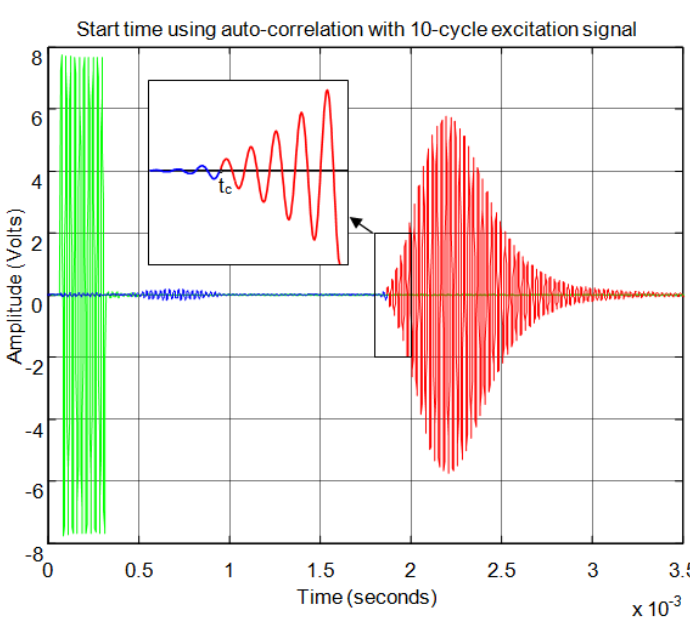
Figure 14. Start time of the echo using